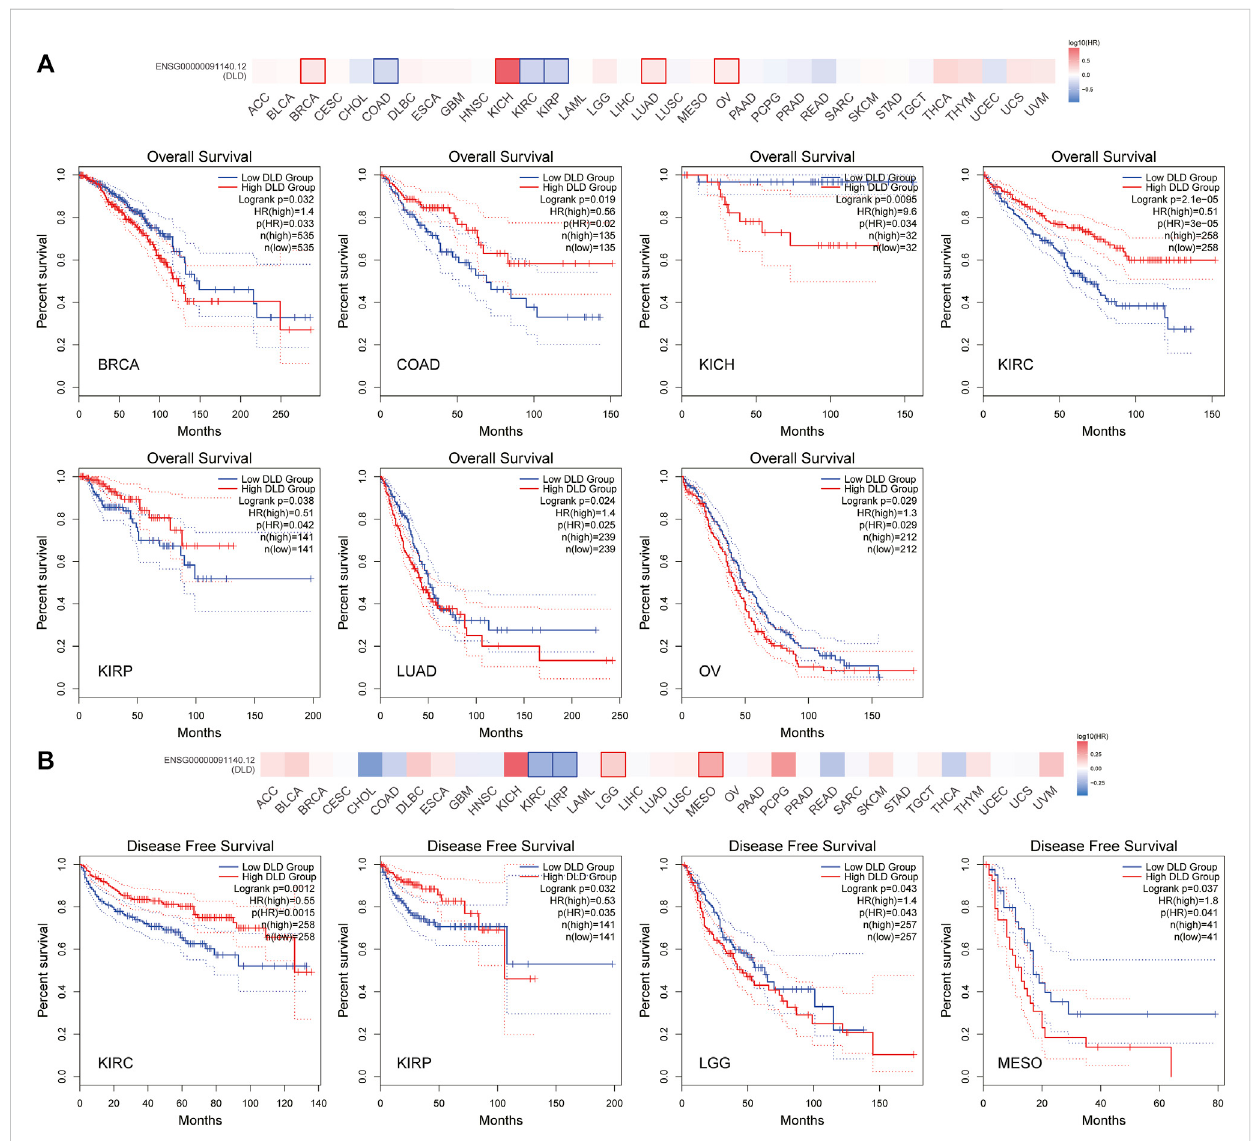
FIGURE 4 Survival analysis of DLD in pancancer data from the GEPIA2.0 database. (A) The impact of DLD expression on overall survival. (B) The impact of DLD expression on disease-free